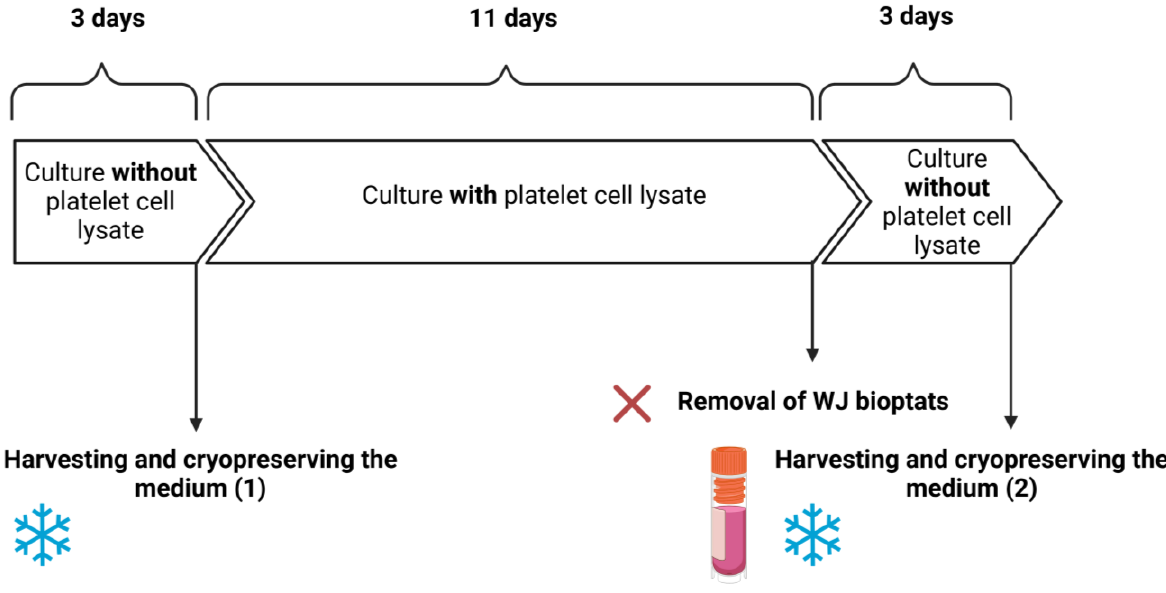
Figure 10. Experimental